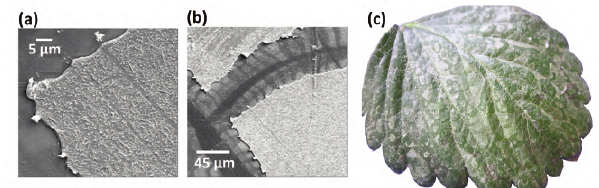
Fig. 2 ­ Electron micrograph of the phytoprotective film of Chi­ Pyro­Film, after spraying on a smooth surface at a tem­ perature of 18 to 25°C (a and b). Chitosan strawberry leaf covered with a film formed by Chi­Pyro­Film